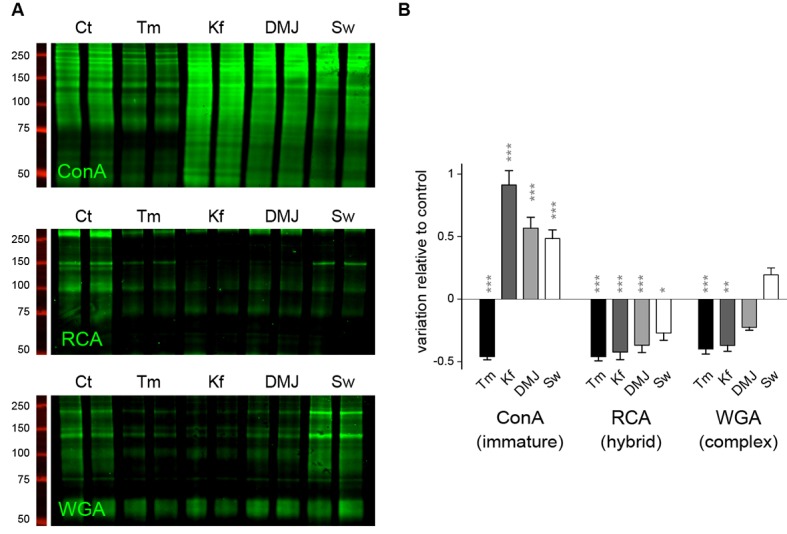
Other examples of dendrites after treatment with the drugs described in Figure 5A.